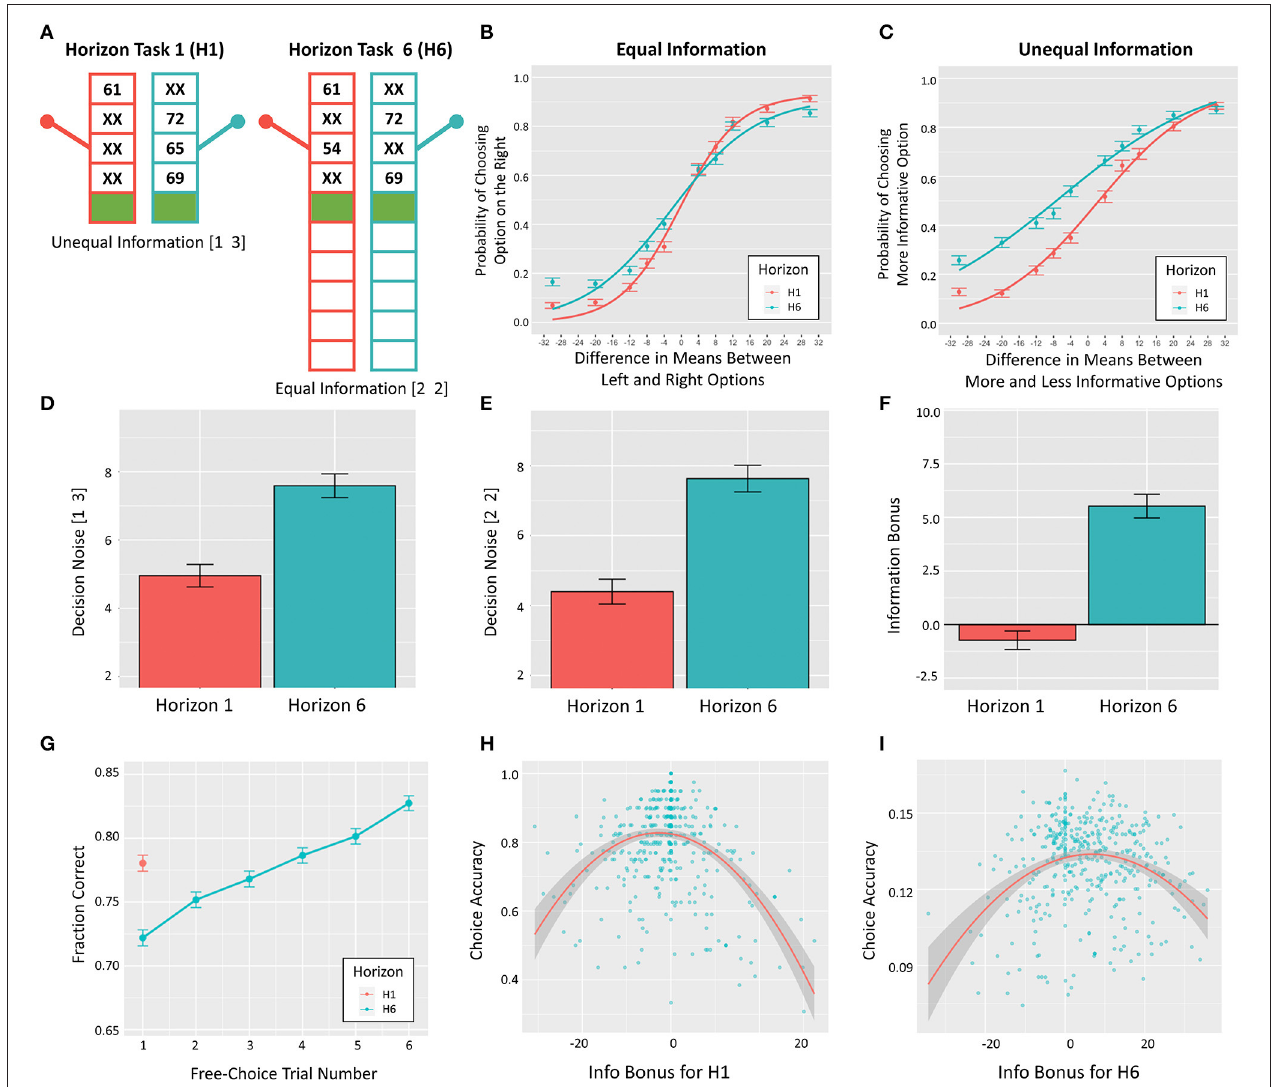
FIGURE 1 | (A) Depiction of example Horizon 1 (H1) and Horizon 6 (H6) games at the first free choice. (B,C) Probability of choosing the option on the right depending on differences in the generative means of the two options. (D,E) . Estimates of decision noise in H1 and H6 games (within equal and unequal information conditions), showing the predicted pattern of greater noise in H6 games. (F) Estimates of information bonus in H1 and H6 games, showing the predicted pattern of greater information bonus values in H6 games. (G) Fraction of correct responses (i.e., choice of the option with the higher generative mean) for each trial in H1 and H6 games. (H,I) Inverted-U relationship between information bonus and choice accuracy (i.e., choice of the option with the higher true mean) in H1 and H6